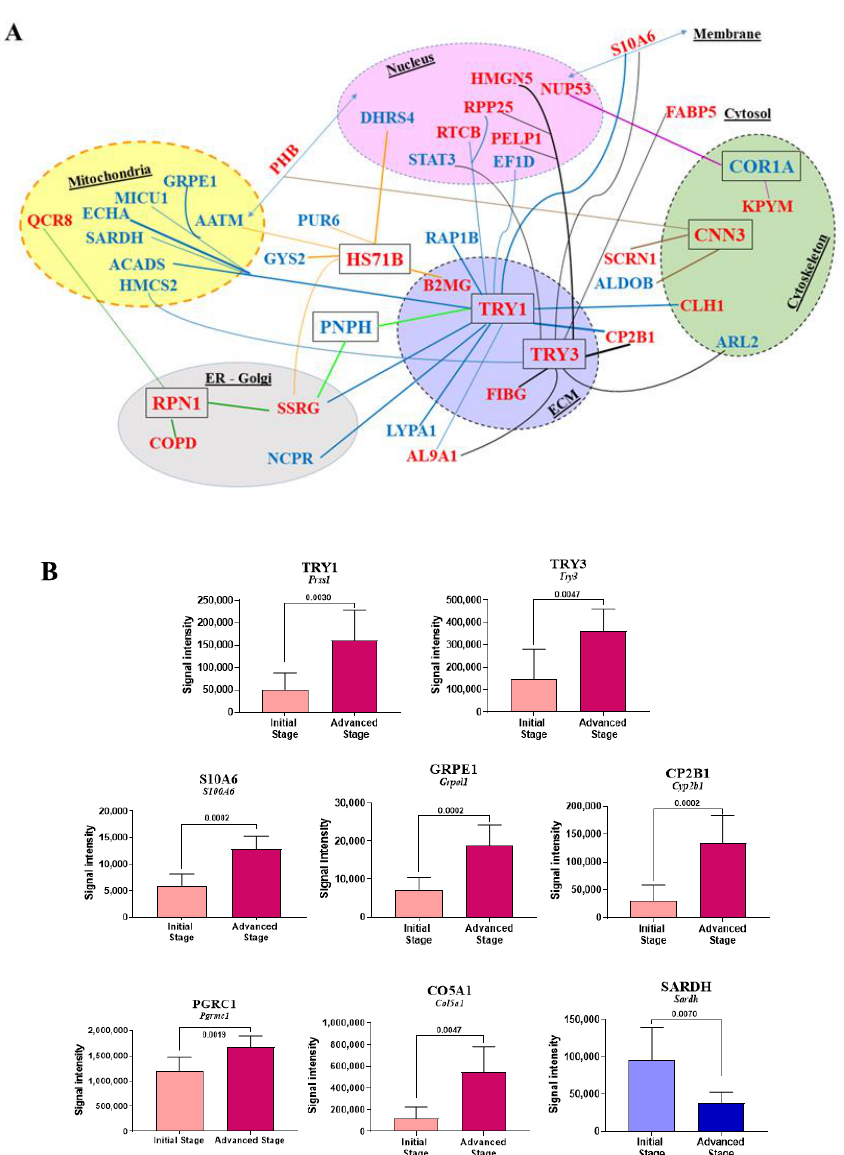
Figure 7. Main correlations observed between biomarkers identified in Sections 2.2–2.5. ( A ) Subcellular locations of proteins of interest are represented by different colors (except for cytoplasm/cytosol). Proteins distributed between several subcellular compartments are labeled with double-headed arrows. The p -values < 0.01 observed between PNPH, the 179 biomarkers described in Section 2.3 (see Figures 3 and 4), and each of the seven proteins finally identified in Figure 7C are symbolized by lines of different colors. ( B ) Most significant protein abundance changes in the liver between the two stages of M5-T1 tumor development defined in Section 4.2 and illustrated in Figure 1B,C.